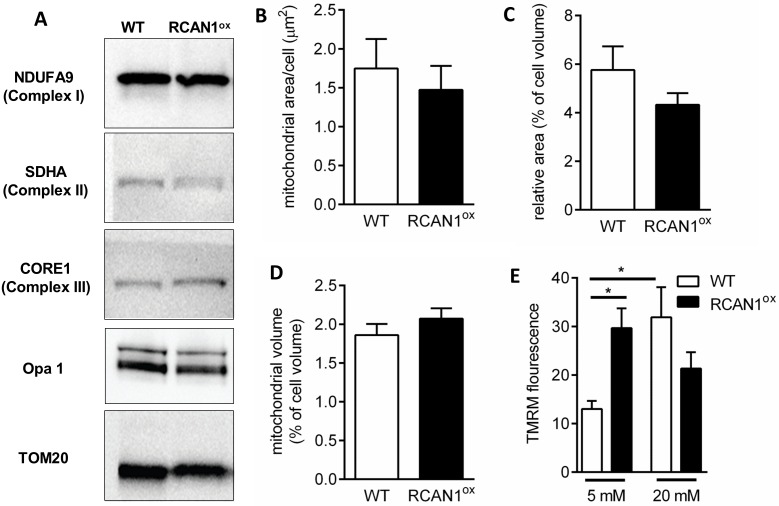
RCAN1 effects mitochondrial membrane potential, not volume.(A) Representative western blots of wild type (WT) and RCAN1ox islet protein lysates probed against NDUFA9, SDHA, CORE1, Opa1 and TOM20. Electron microscopy analysis of (B) total mitochondrial area and (C) relative area in WT (n = 8 β-cells) and RCAN1ox (n = 6 β-cells). (D) TMRM staining in live cells further demonstrates a lack of difference in mitochondrial volume between WT (n = 43 cells) and RCAN1ox (n = 46 cells). (E) Mitochondrial membrane potential measured as mean cell TMRM fluorescence in low and high glucose in WT and RCAN1ox cells (n = 17–21 cell/group). Data represents the mean ±SEM, *p<0.05.